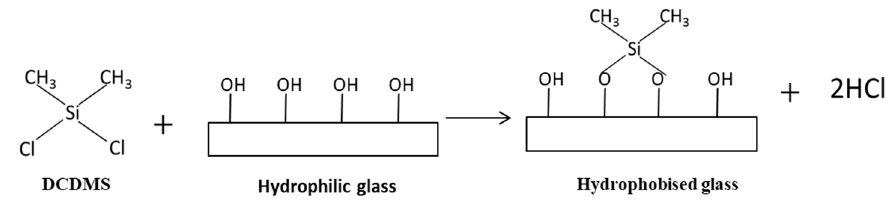
Figure 2. Microscope images of the smooth glass ( left ) and rough glass at different magnifications ( middle and right ), respectively. Scale bars (from left to right ) represent 100, 200 and 100